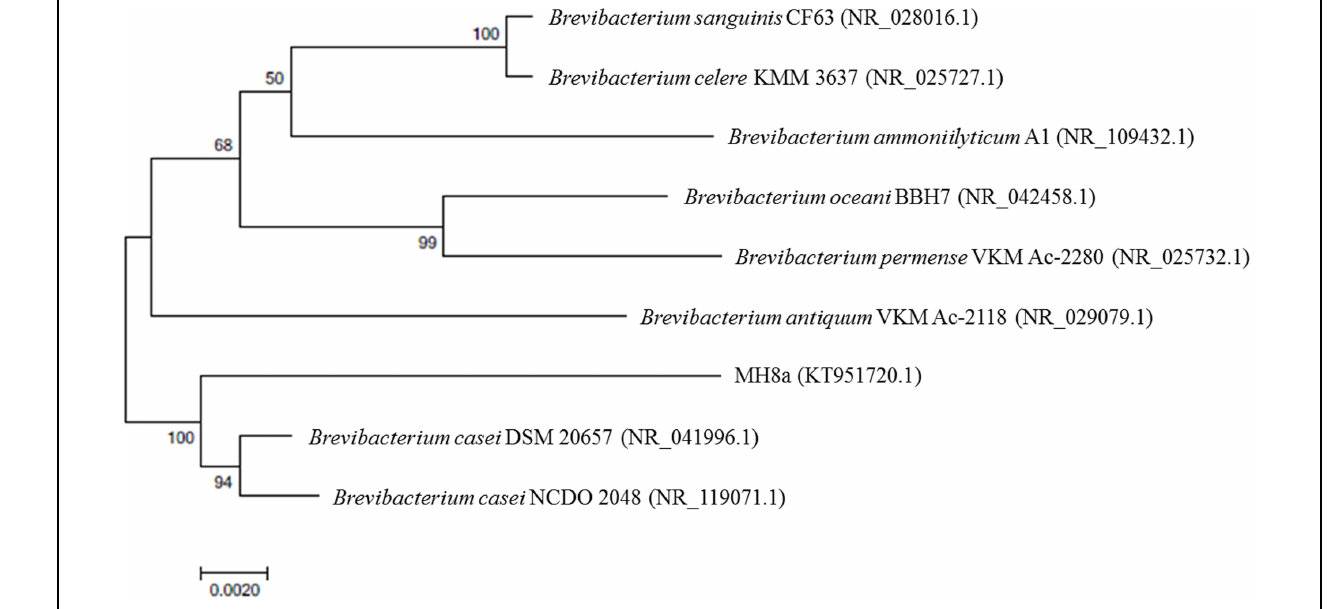
branched fatty acids and an increase of 18:2 ω 6,9c as compared with the PLFA profiles from the 24 h and 7 days